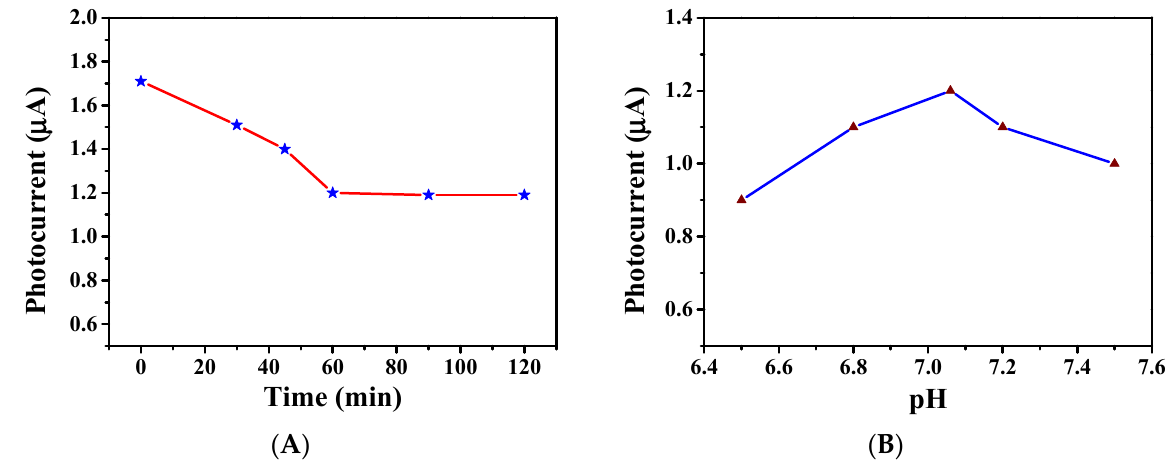
Figure 5. Factors affecting the PEC performance of the constructed electrode, ( A ) incubation time, and ( B ) pH value. The pH value of PBS solution used in the experiment was 7.06, and the pH value was adjusted with dilute hydrochloric acid and sodium hydroxide solution to analyze the effects of pH values on photocurrent. After 10 μ L 50 nM T-DNA was drip-coated and